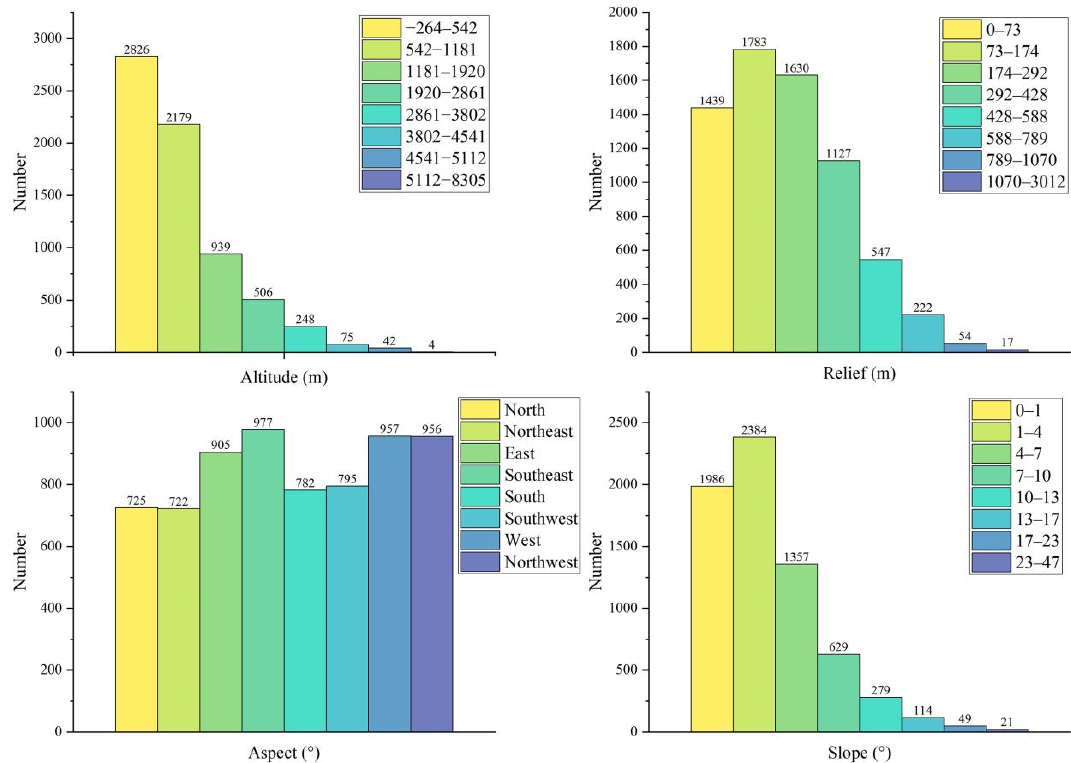
Figure 10. Statistics of traditional villages in different geographical conditions.